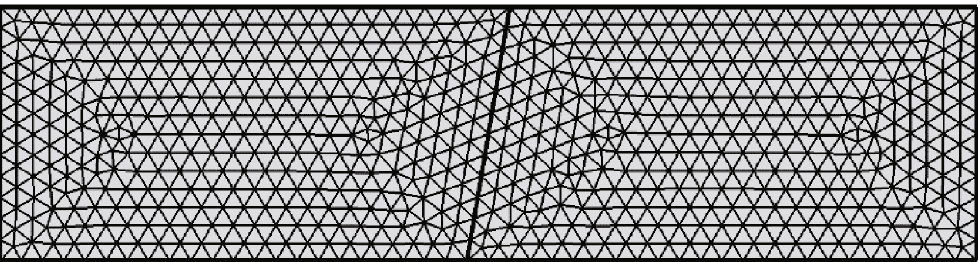
Figure 2: The meshing of the geometry with irregular triangular elements.